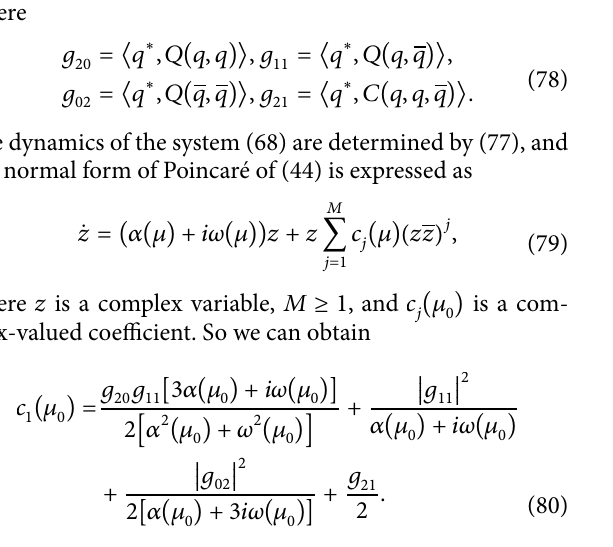
of (4) becomes unstable for (3) for